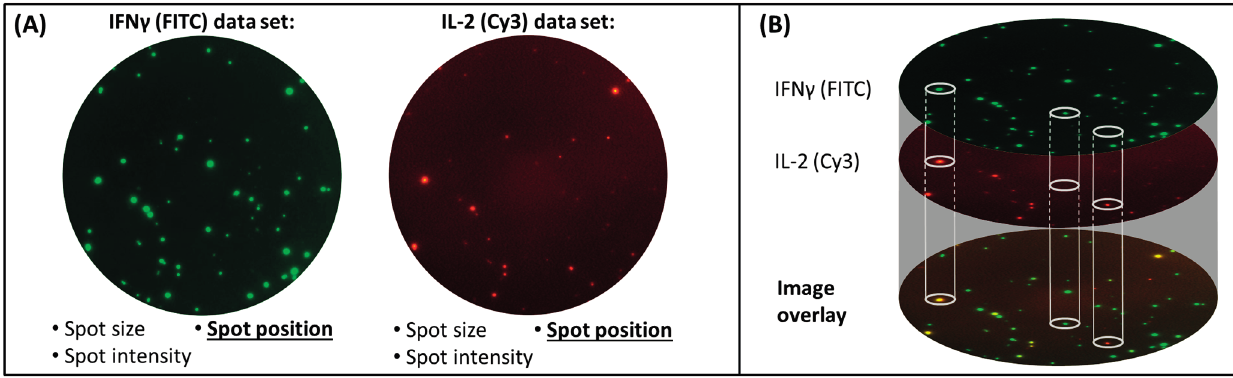
Figure 3. Two level FluoroSpot analysis. PBMC were stimulated with CEF peptide pool and tested simultaneously for IFN ɣ and IL-2 secretion using FITC (for IFN ɣ ) and Cy3 (for IL-2) fluorophores. Images were taken with an AID Imaging Analyzer utilizing narrow band filters for each fluorophore. Panel ( A ) demonstrates the two separate images taken of the same well (Level one analysis). Spots are analyzed for e.g., spot size, spot intensity and location. Images are then superimposed and a location algorithm is applied that allows the identification of spots resulting from single and dual cytokine-producing cells based on the exact location parameters of each spot center (Level two analysis, panel ( B